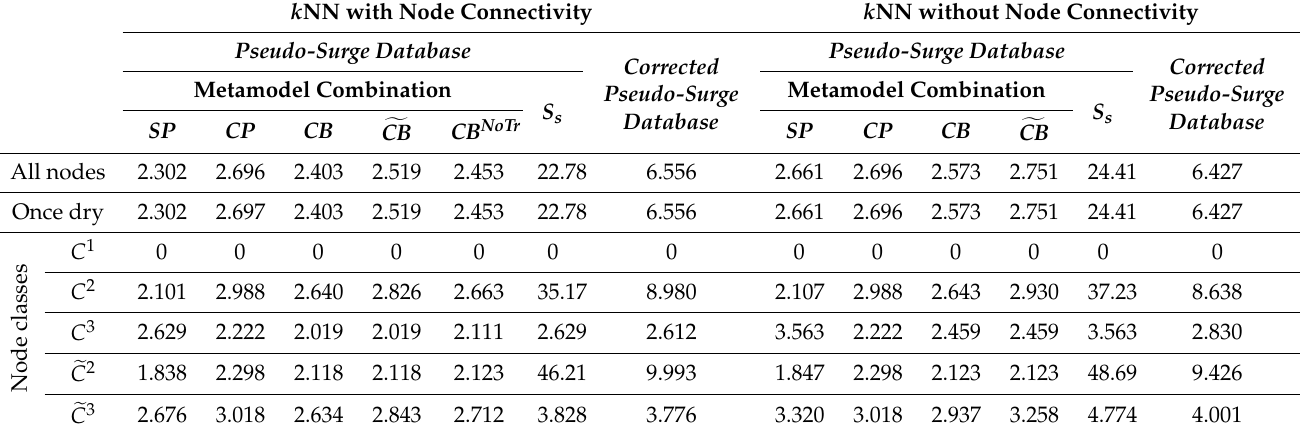
Table 5. False-positive misclassification ( + MC ) percentage for different variants and different groups of